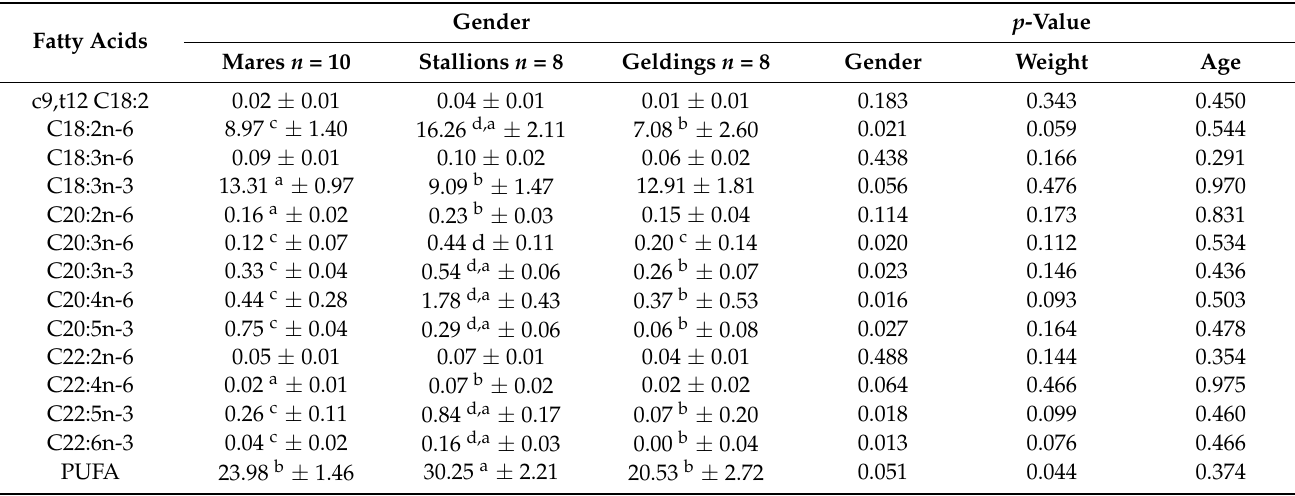
Table 8. Effects of gender, age, and carcass weight on polyunsaturated fatty acid (% of total FA) composition of horse meat lipids.